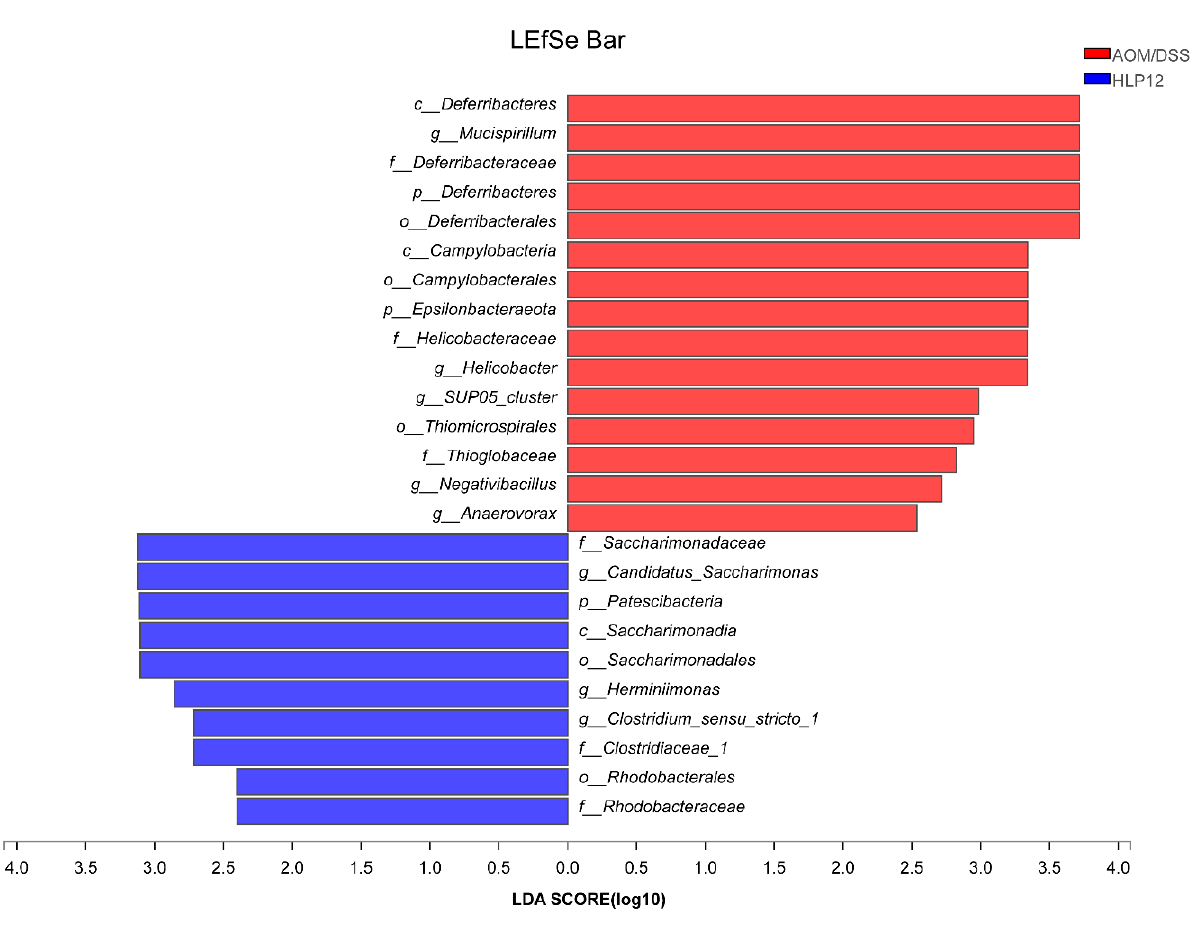
Figure 10. LEfSe analysis of fecal microbiota of AOM/DSS-treated mice ( n = 5). Biomarker taxa generated from LEfSe analysis (LDA > 2.0) between AOM/DSS and HLP12.